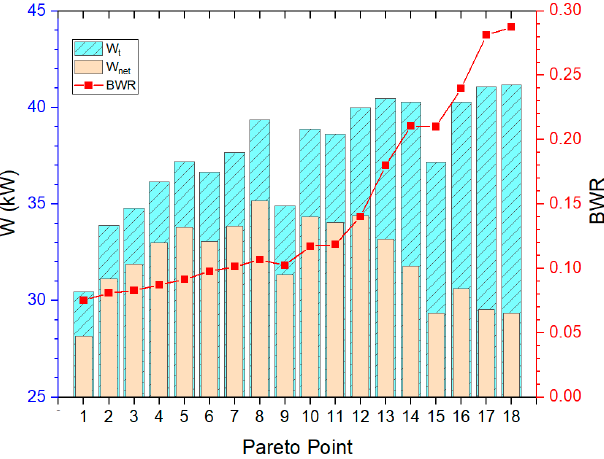
Figure 5. The net output power, gross power, and BWR at the Pareto frontier point.